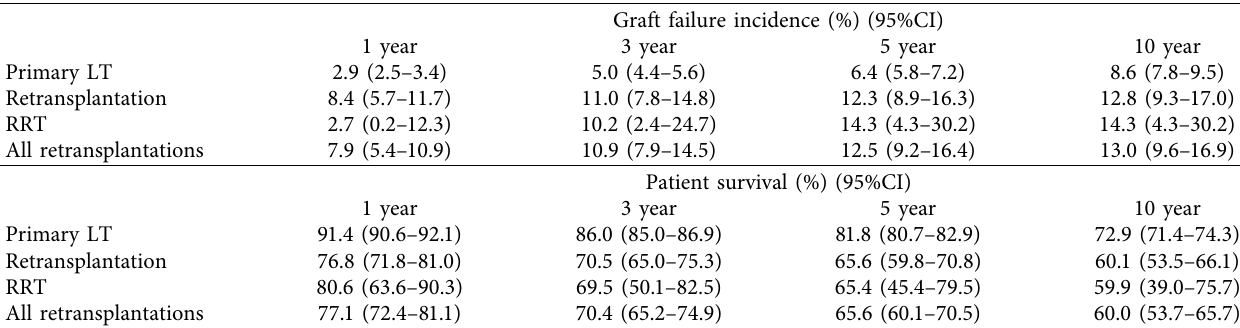
Table 3: Graft failure incidence and patient survival at various time points according to the number of